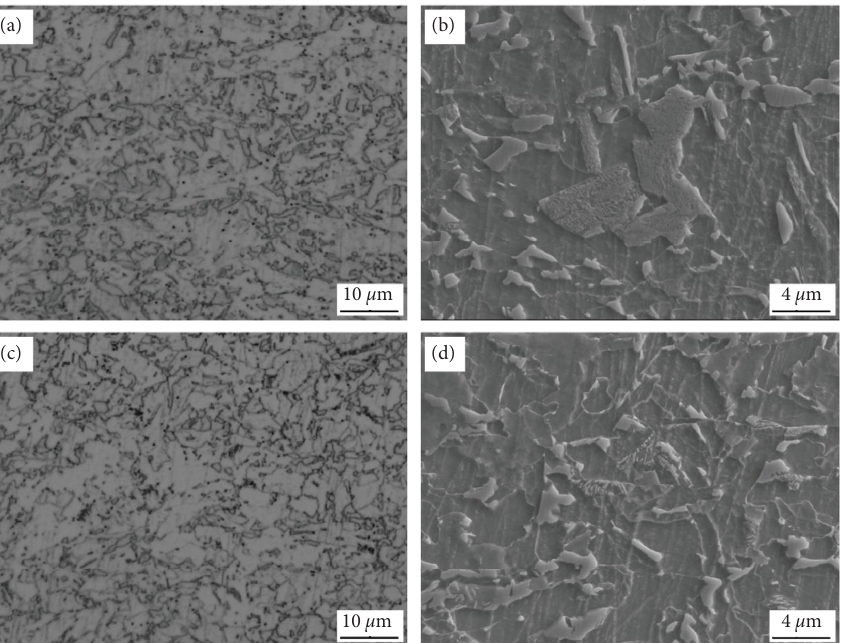
Figure 3: Microstructure images of experimental steels. (a, b) OM micrograph and SEM micrograph of steel A. (c, d) OM micrograph and SEM micrograph of steel